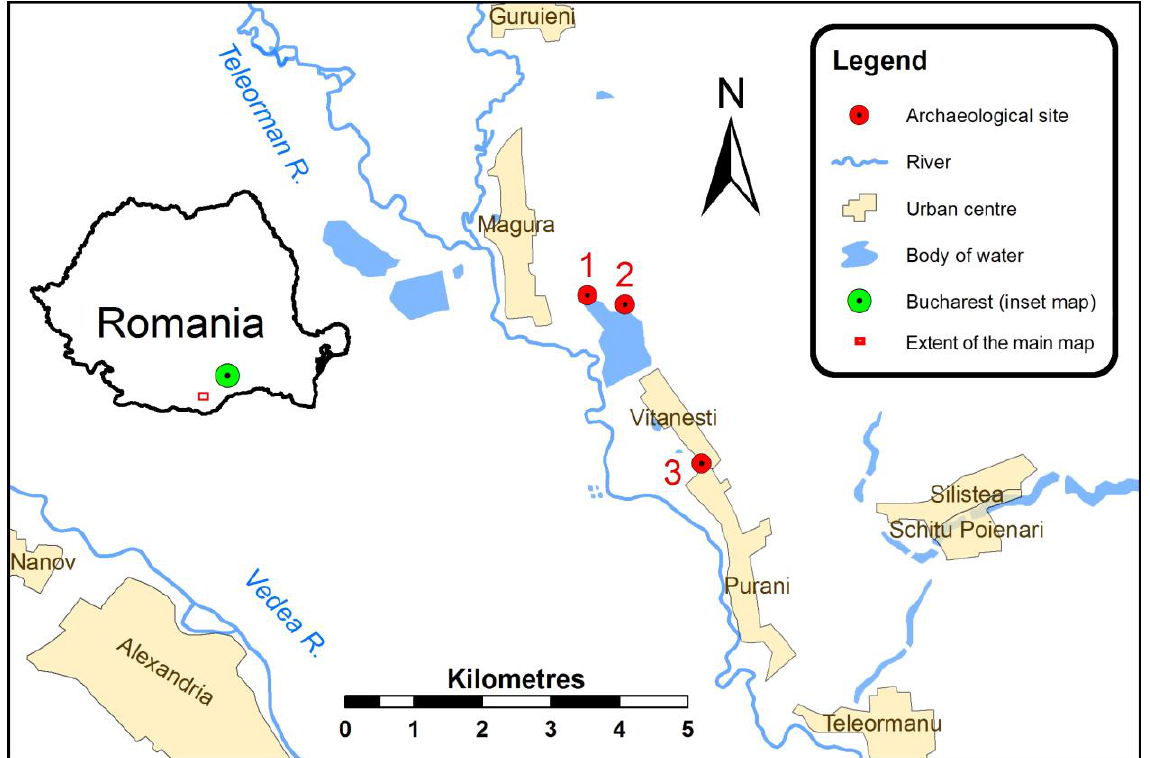
Figure 1. Location of the archaeological sites: 1. & 2. Măgura ‘Buduiasca’, 2. ‘Boldul lui Moș Ivănuș’ component; 3. Vităneşti ‘Măgurice’. The inset map of Romania shows the location of the